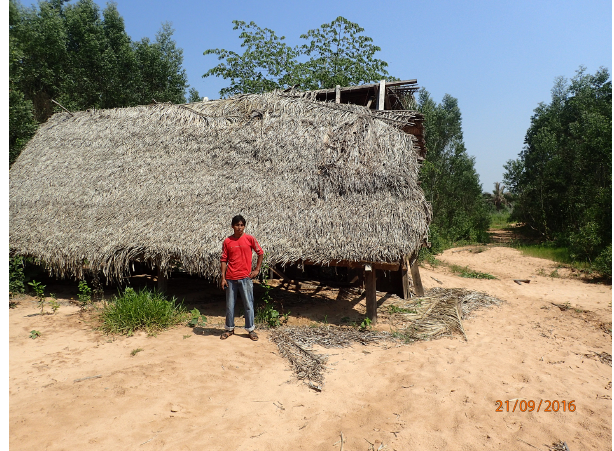
Figure 10. Sand layer deposited overnight in 2016 by the Colorado River in the community of Inka Agropecuaria. The posts of the hut were originally 3m above the surface; after the deposition only the topmost meter remained above the sand. The house is about 100m from the Colorado River and about 1km upriver from the point at which the 2016 logjam formed (Fig. 3). The trees behind and on the right of the house are 7-month-old parajobobos.